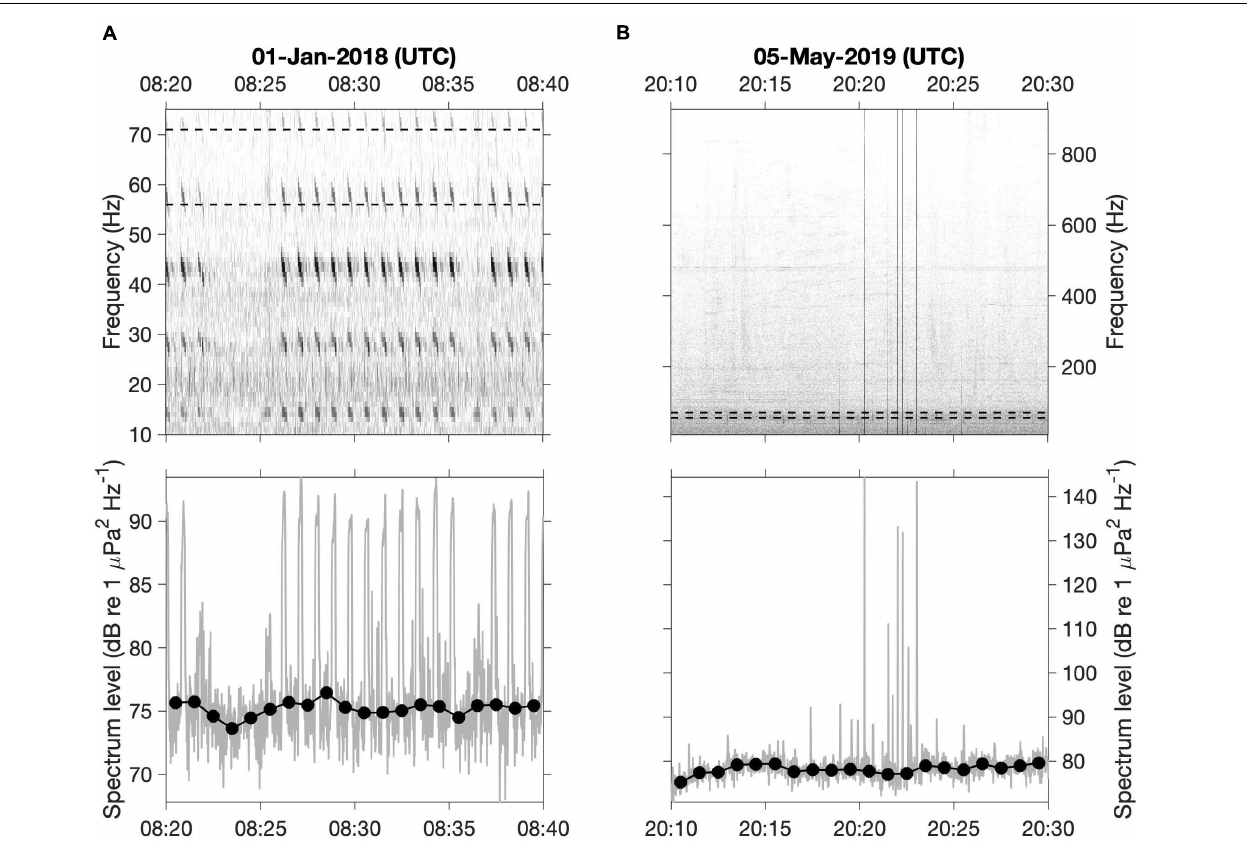
FIGURE 3 | Non-shipping signals in the focal frequency band. Focal signals are (A) the fourth harmonic of the blue whale B call, and (B) bio-abrasion (mechanical disturbance of the recorder by an animal). Spectrograms (top) were computed using 2 kHz data (decimated from 256 kHz), 2,000 pt. FFT, Hanning window, no overlap; the 63-Hz one-third octave band is represented by dashed lines. Spectrum levels within the focal frequency band (bottom) are represented for 1-s resolution (gray) and 1-min L50